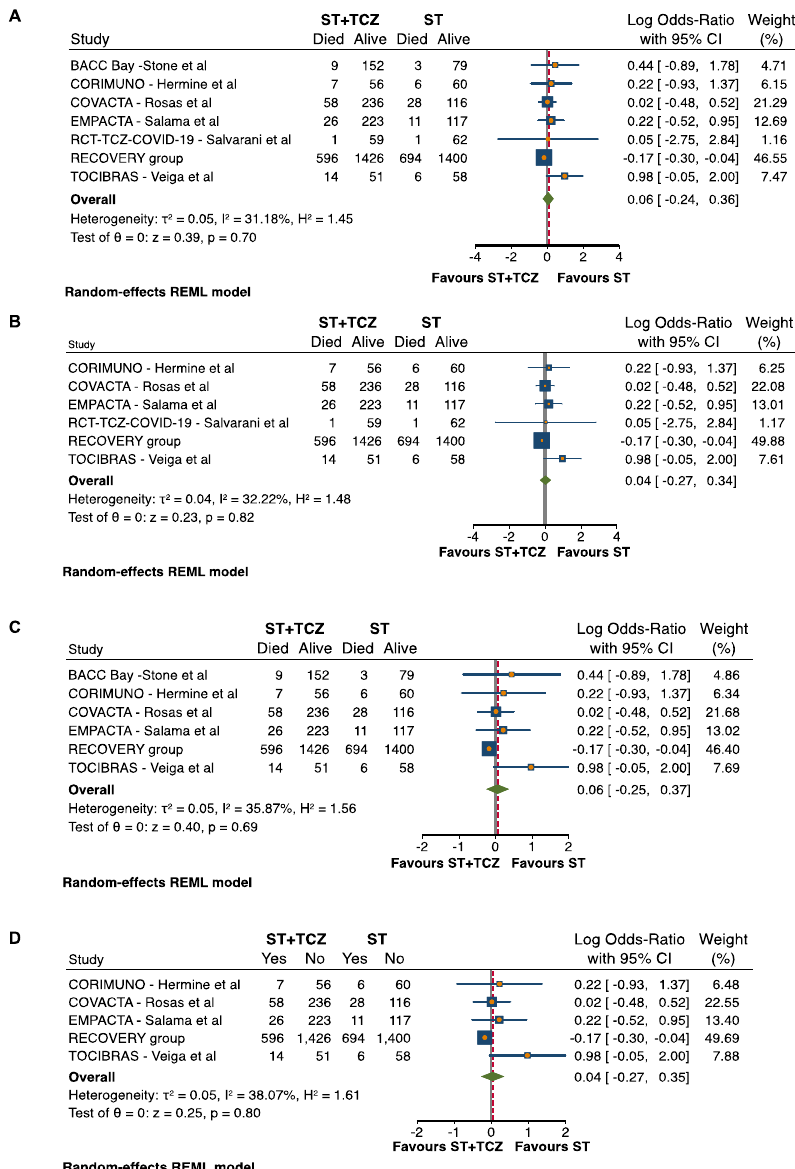
Figure 2. Forest plot in ( A ) RCTs and ( B ) observational studies. ( C ) Funnel plot of the subgroup analysis by RCTs and observational studies.